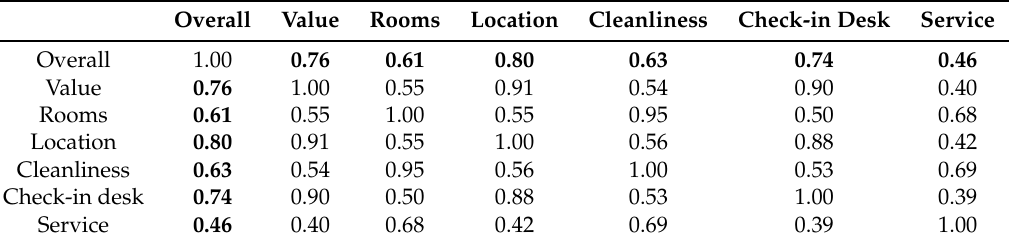
Table 4. Pearson correlation matrix of the dataset.